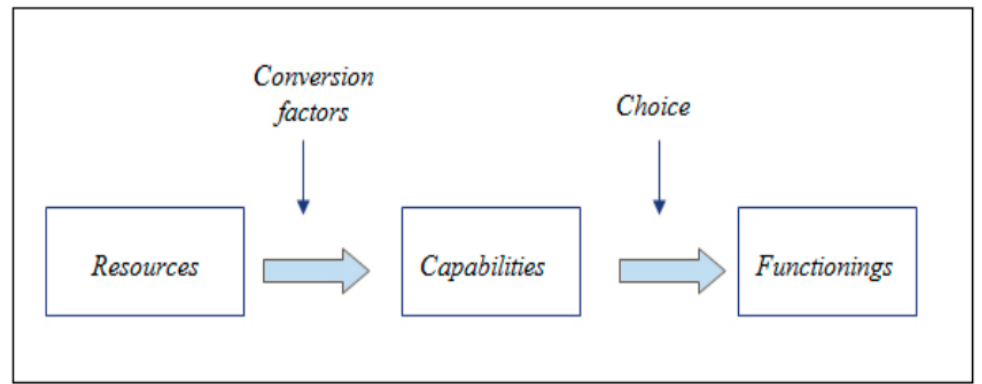
Figure 1. Capability approach adapted from Verd and Andreu [19].